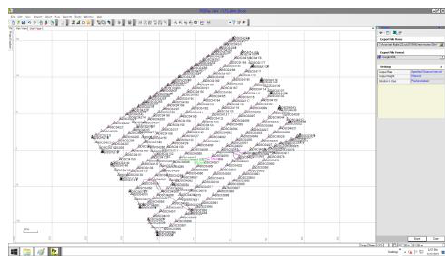
Figure 6: APX-15 UAV trajectory with photo centres